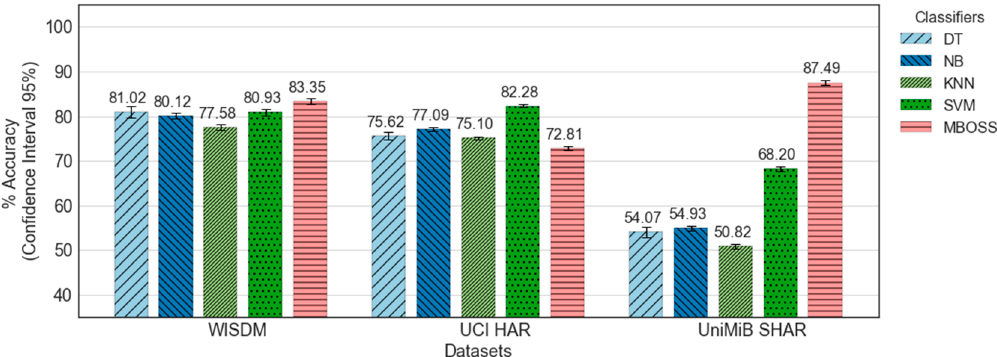
Figure 8. Accuracy results for all classifiers evaluated based on generalized model.